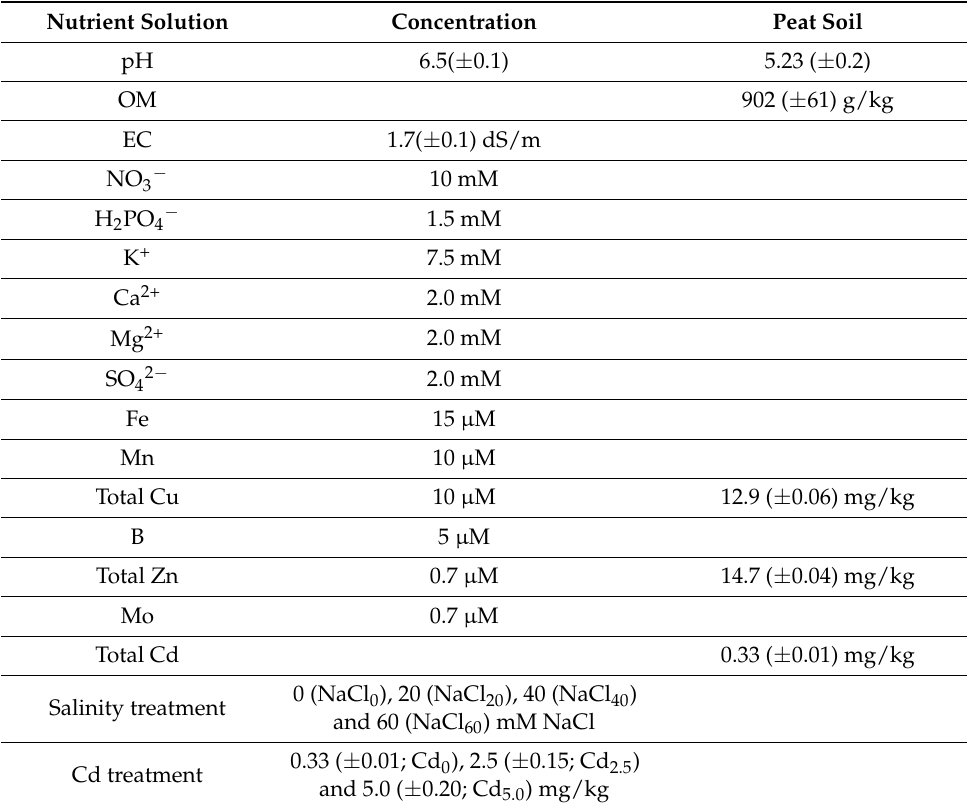
Table 3. Chemical composition of standard nutrient solution, peat soil and the applied treatments. The values in parentheses represent standard errors ( n =